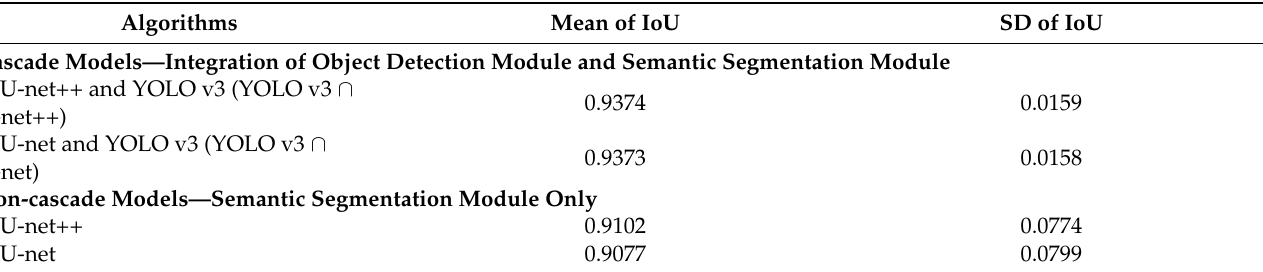
Table 2. Results of the performance of different AI